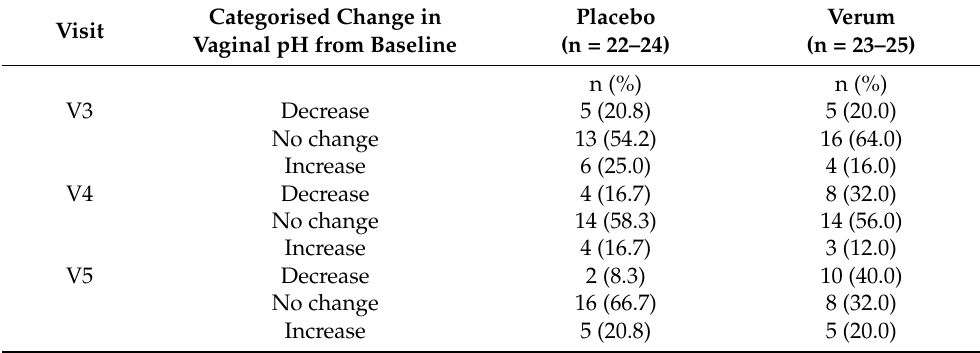
Table 7. Prevalence of change in vaginal pH during the intervention and follow-up measured with after one week of intervention; V4, after two weeks of intervention; V5, after a one-week